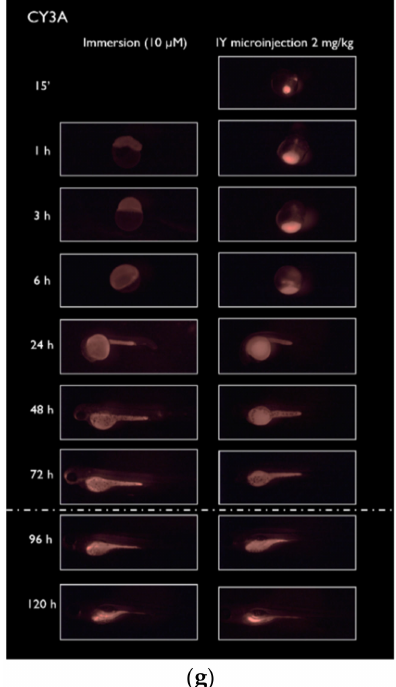
Figure 2. Representative fluorescent images showing the spatiotemporal distribution of the fluorescent dyes in the embryos after immersion (10 µ M) and microinjection (2 mg/kg) for several periods of time. ( a ) animals treated with S-CY3A; ( b ) S-CY5.5A; ( c ) S-CY5A; ( d ) FAMA; ( e ) TAMRA; ( f ) R6GA; ( g ) CY3A. The dash dotted line represents the hatching time and the change of zebrafish medium. 15 (cid:48) = 0.25